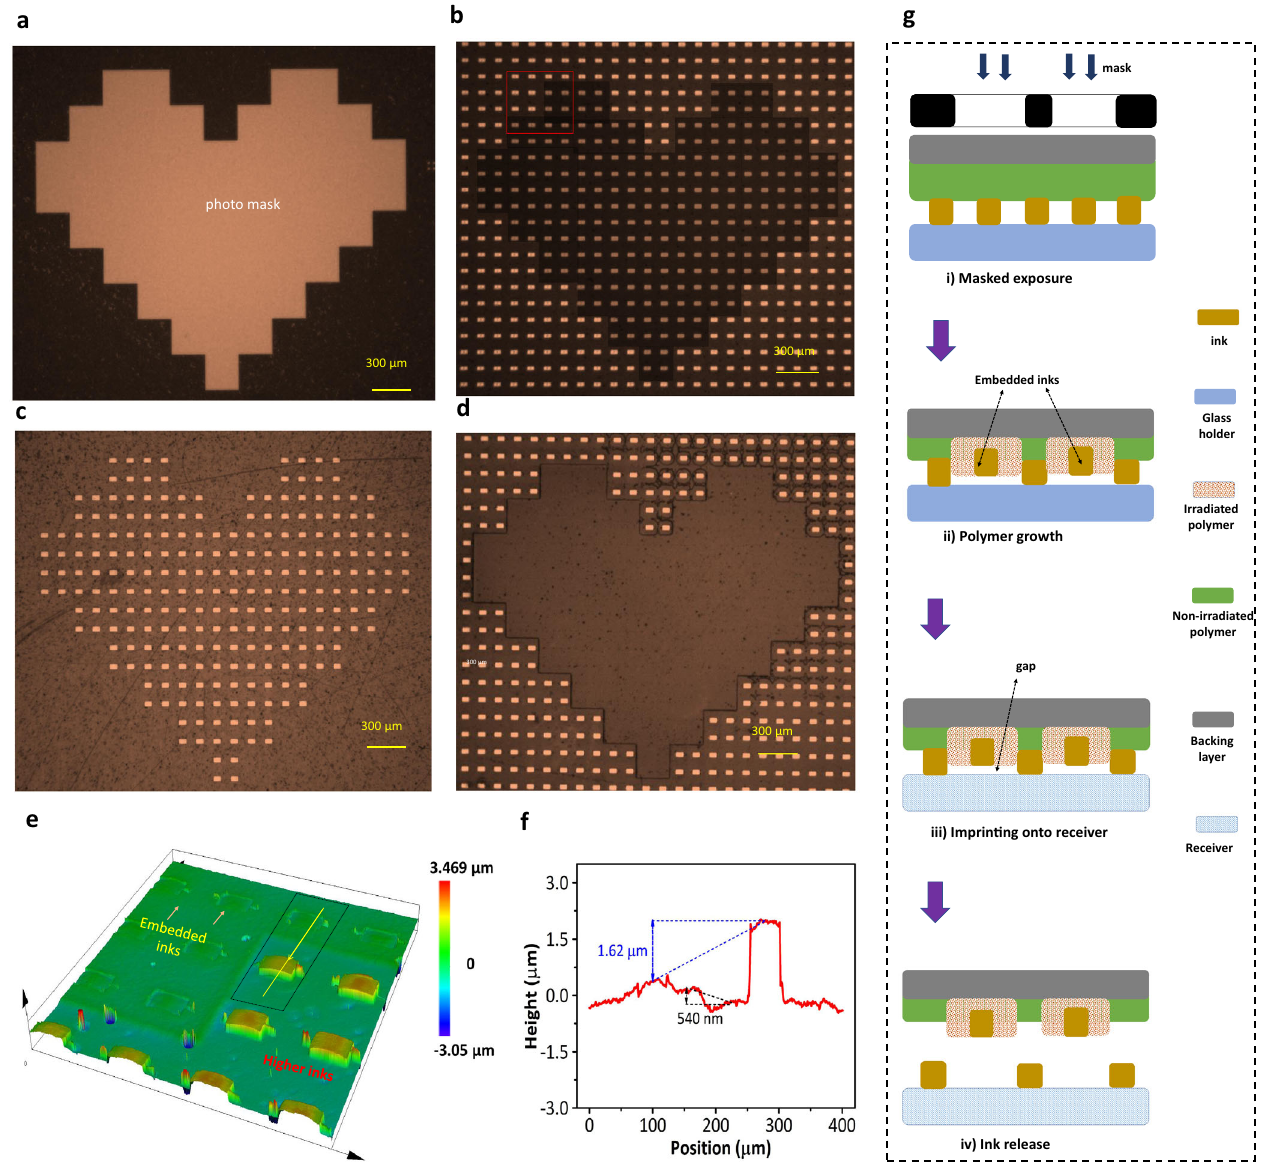
Fig. 4 Programmable transfer printing and its mechanism. a Heart-shaped mask used for selective UV irradiation. b Optical image of the GaN ink array on the photosensitive polymer adhesive before selective exposure. The heart-shaped shadow shown in ( b ) is a guide to the eyes, and corresponds to the region where will be not exposed. c Optical image of the heart-shaped GaN ink array transferred to the receiver by 1.5 s fl ood exposure and 1.5 s selective exposure. d Optical image of the GaN inks left on the original adhesive tape after programmable transfer. e Confocal 3D topography of the GaN ink array and the adhesive surface after mask exposure but before the transfer, revealing the GaN Inks in the masked area are higher, whereas the GaN inks in the exposure area are embedded in the polymer layer. The scanning area is taken from the region marked by the red rectangle shown in ( b ). f Height pro fi le of the GaN devices scanning along the yellow line marked in ( e ). g Schematical illustration of the working principle of programmable transfer. A gap is formed between the irradiation area and masked area, due to the light-induced polymer redistribution. GaN Inks in the exposure area are completely sucked in the irradiated polymer. This is the major reason why the GaN inks in the masked region are transferred to the fi nal